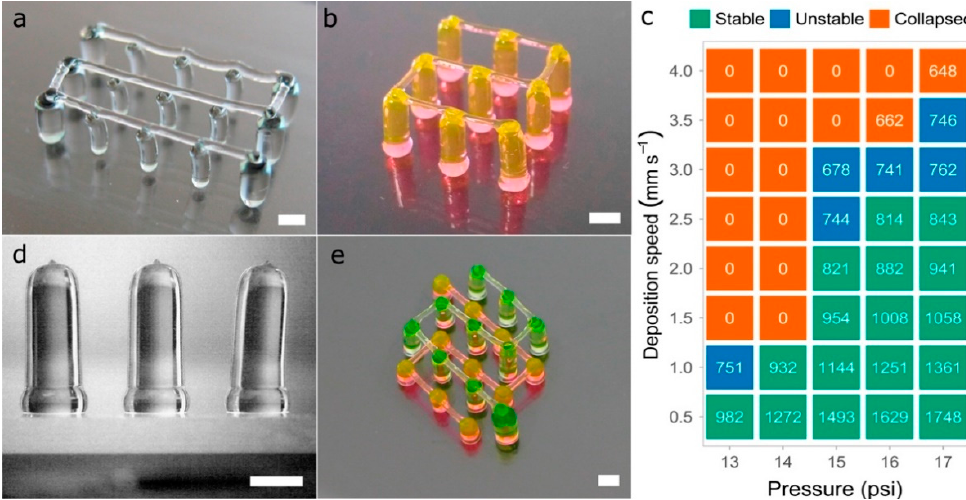
Figure 16. ( a , b ) complex vascular 3D networks printed in P407; ( c ) evaluation of the stability of 3D printed vertical pillars for a fixed height of 8 mm. Printing pressure ranging from 13 psi to 17 psi and deposition speeds ranging from 0.5 mm s − 1 to 4 mm s − 1 . The data inside the figure represents the mean of pillars diameter (in μ m) of six different samples ( n = 6); ( d ) side view of 3D printed 4 mm height pillars; ( e ) vascular structure printed at two different heights (2 mm and 5 mm) with interconnected bridges; scale bars: 1 mm.